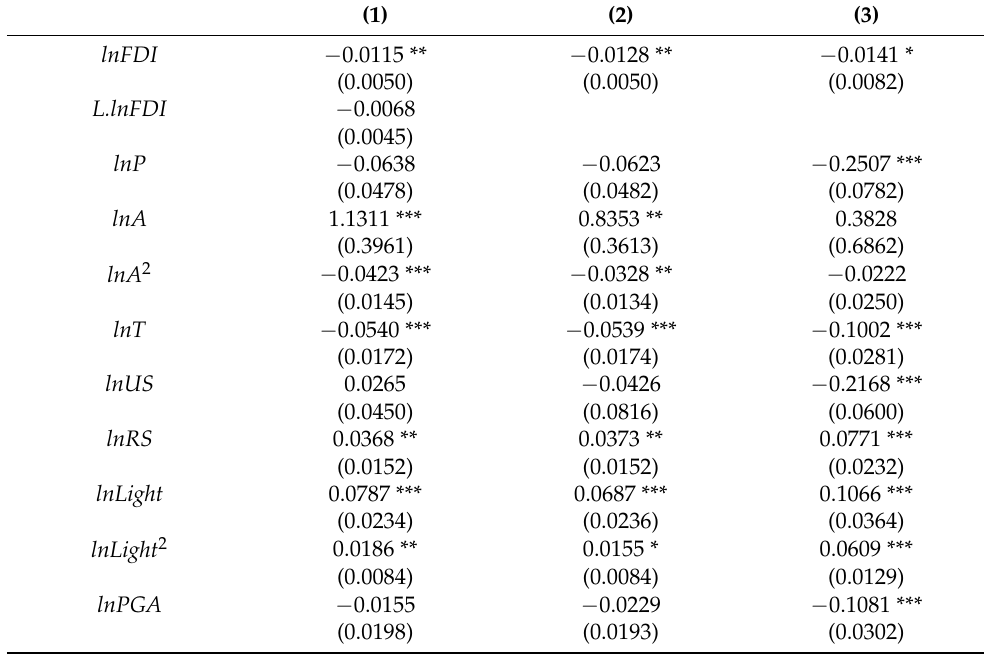
Table 6. Robustness